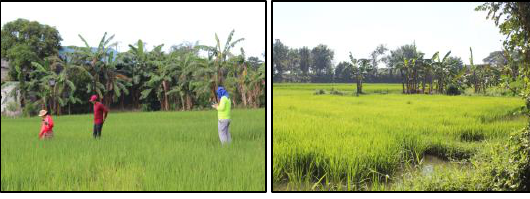
Figure 2. Rice Plantation